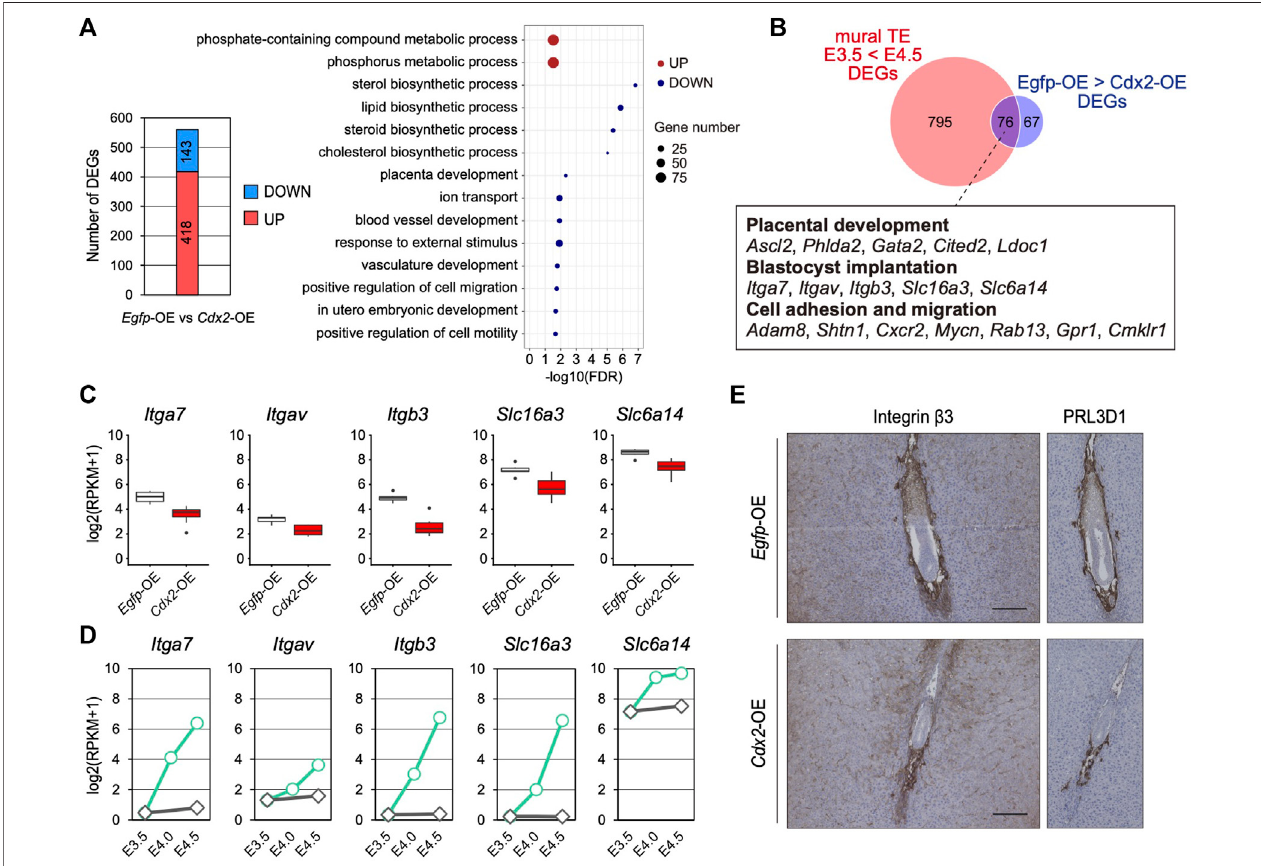
FIGURE4| The effect of Cdx2 on themTE geneexpression (A) Thenumber ofDEGsbetween Egfp -OE and Cdx2 -OE blastocysts,and GO terms withpreferential gene enrichment. In bubble plot, the size of each dot represents the number of genes enriched in the GO terms, while difference is shown by color: red, GO terms containingtheup-regulatedDEGs;blue, GOtermscontainingthedown-regulated DEGs (B) VenndiagramshowingtheoverlapofupregulatedDEGsinthemTEatE4.5 compared to E3.5 and downregulated DEGs in LV- Cdx2 -transduced blastocysts compared to LV- Egfp -transduced blastocysts (C) mRNA levels of Itga7 , Itgav , Itgb3 , Slc16a3 and Slc6a14 in Egfp -OE and Cdx2 -OE blastocysts (D) mRNA levels of Itga7 , Itgav , Itgb3 , Slc16a3 and Slc6a14 in each stage of the mTE (E) E5.5 conceptuses labelled for ITGB3 and PRL3D1. The images of PRL3D1 staining were the same as in Figure 3G .